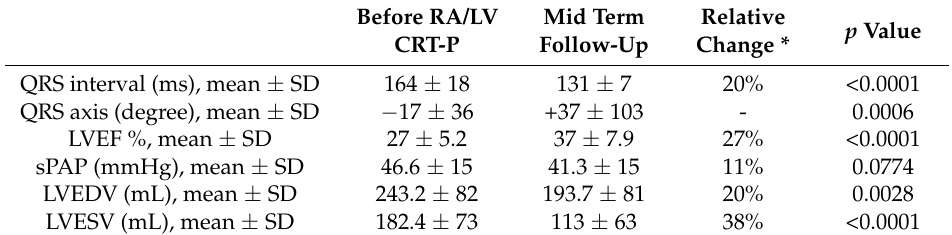
Electrical and echocardiographic parameters at baseline and after cardiac resynchronization